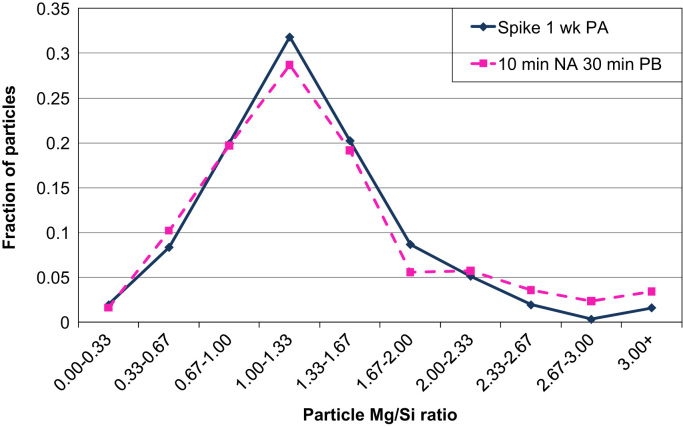
Fraction of particles containing fewer than 150 solute atoms plotted against particle Mg/Si ratio ranges after a spike followed by 1 week PA or after 10 min NA and a 30 min PB as measured by LAR-3DAP.